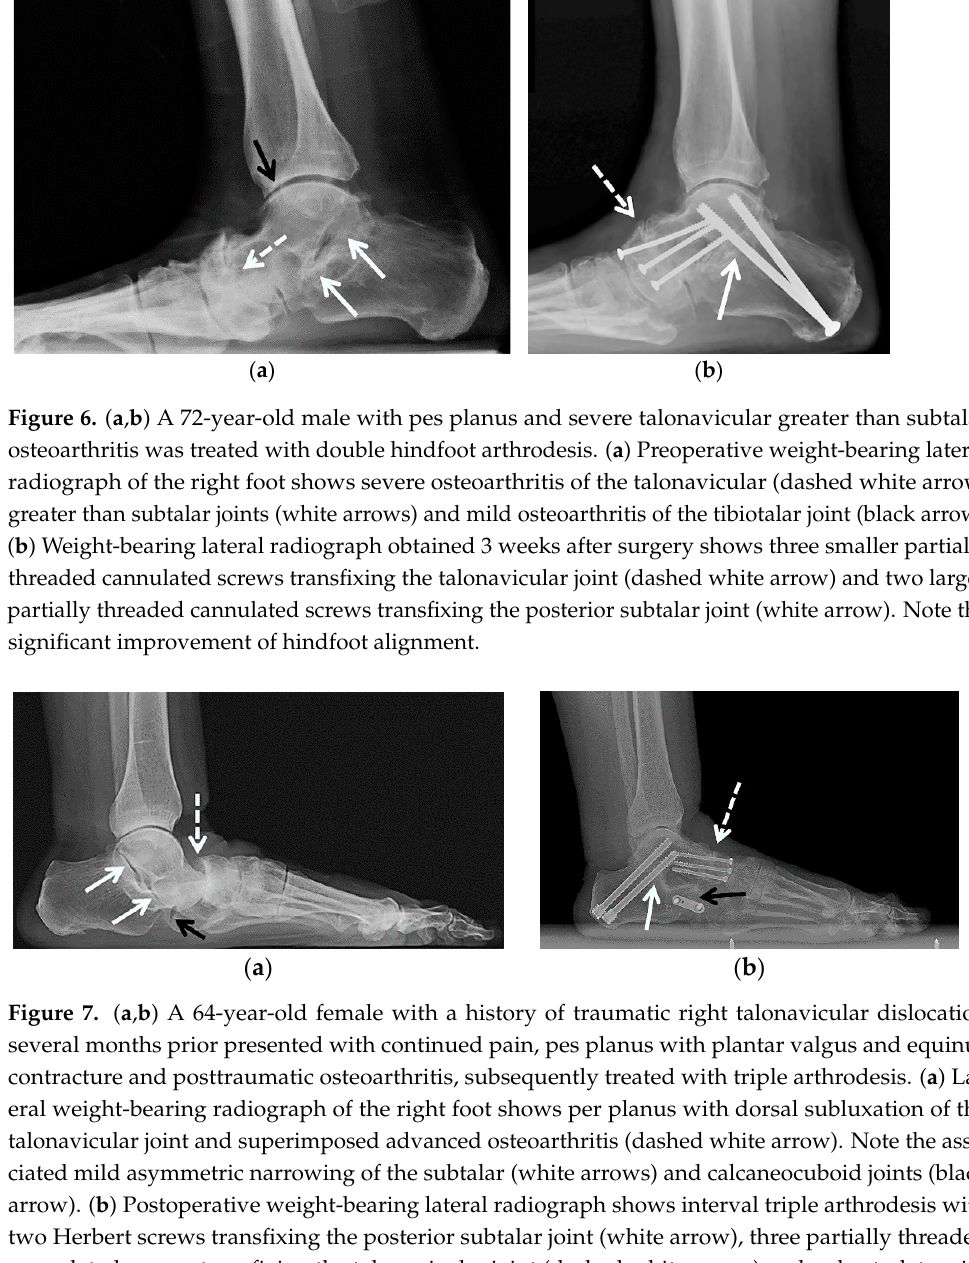
Figure 6. ( a , b ) A 72-year-old male with pes planus and severe talonavicular greater than subtalar osteoarthritis was treated with double hindfoot arthrodesis. ( a ) Preoperative weight-bearing lateral radiograph of the right foot shows severe osteoarthritis of the talonavicular (dashed white arrow) greater than subtalar joints (white arrows) and mild osteoarthritis of the tibiotalar joint (black ar- row). ( b ) Weight-bearing lateral radiograph obtained 3 weeks after surgery shows three smaller partially threaded cannulated screws transfixing the talonavicular joint (dashed white arrow) and two larger, partially threaded cannulated screws transfixing the posterior subtalar joint (white ar- row). Note the significant improvement of hindfoot alignment.